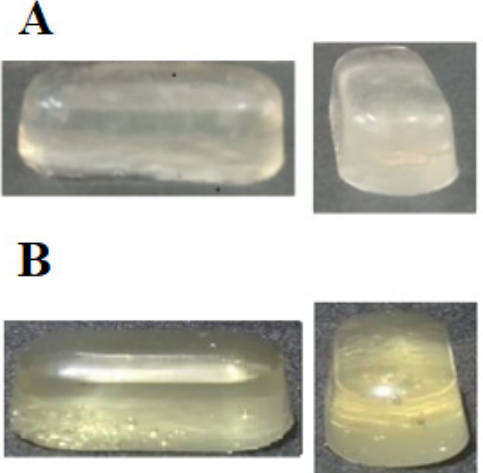
Figure 5. The appearance of soft capsules: ( A ) composite capsule and ( B ) control capsule.